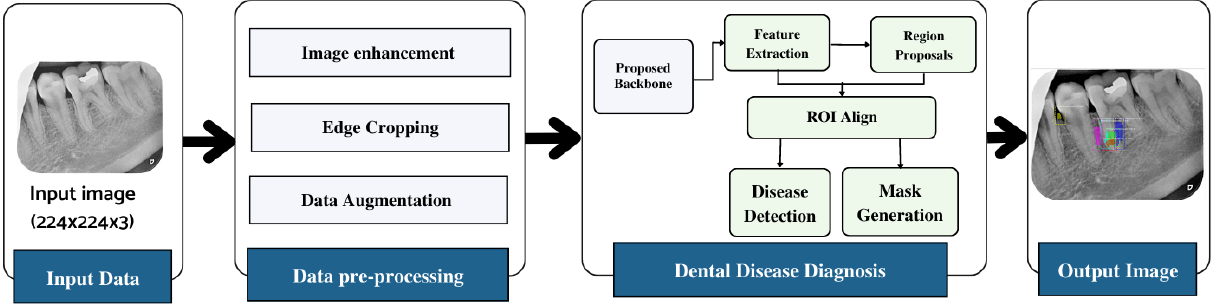
Figure 1. Workflow diagram of the proposed approach.